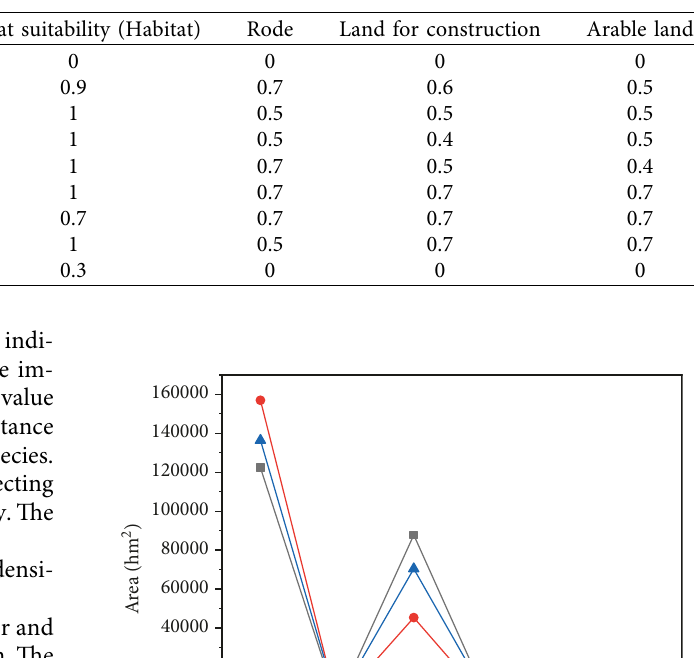
Table 5: Sensitivity of land cover types to various threat factors.